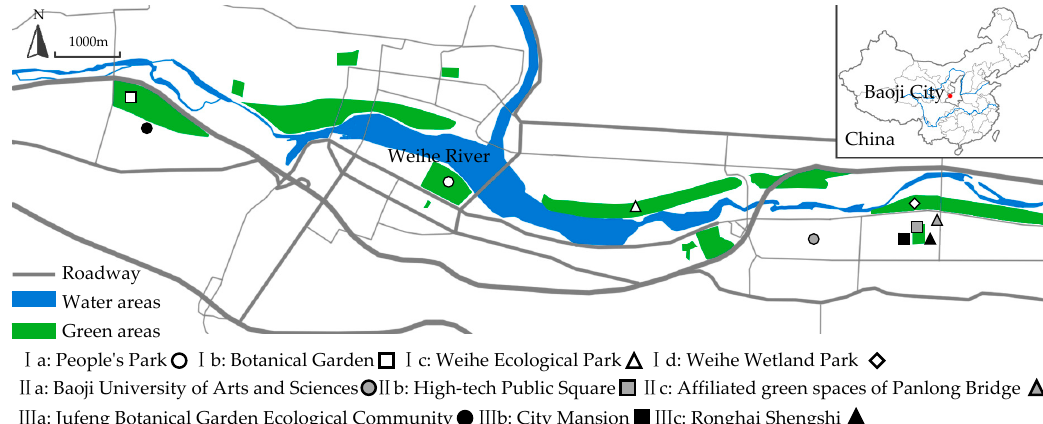
Figure 1. Location of the study sites (I–III).